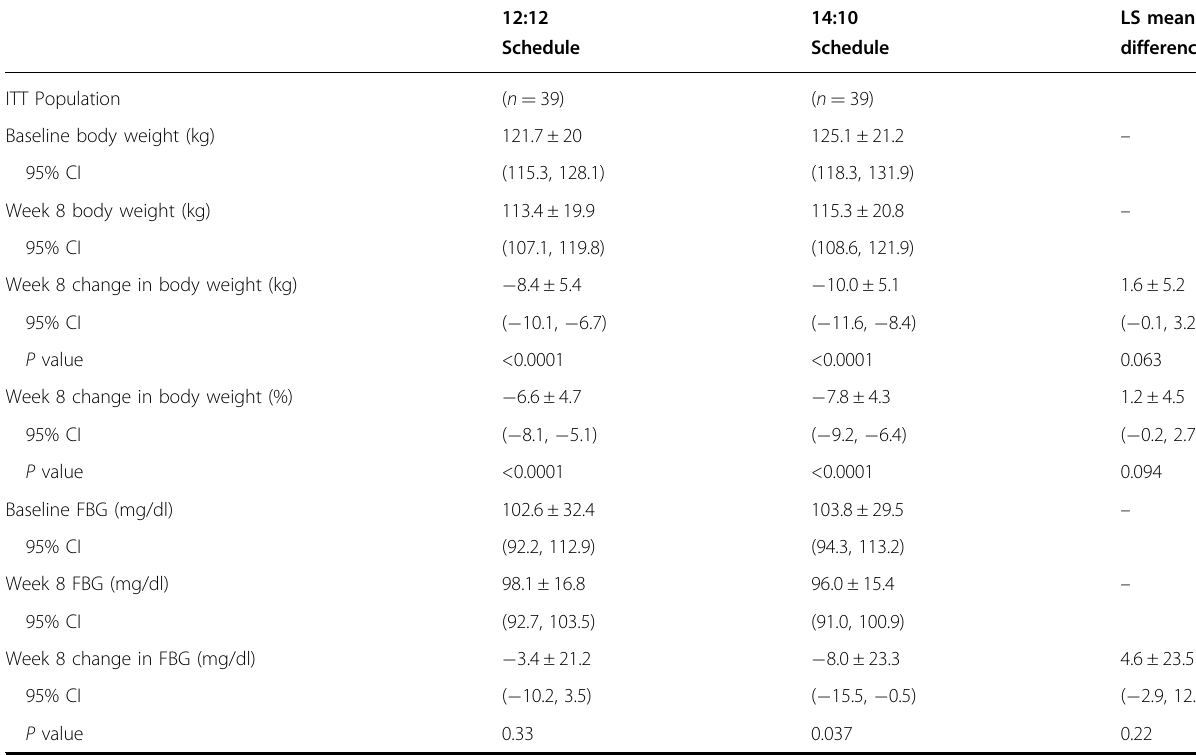
Data are LS mean±SD. The intent to treat population includes all randomized participants. Missing data were imputed using the last observation carried forward method. FBG fasting blood